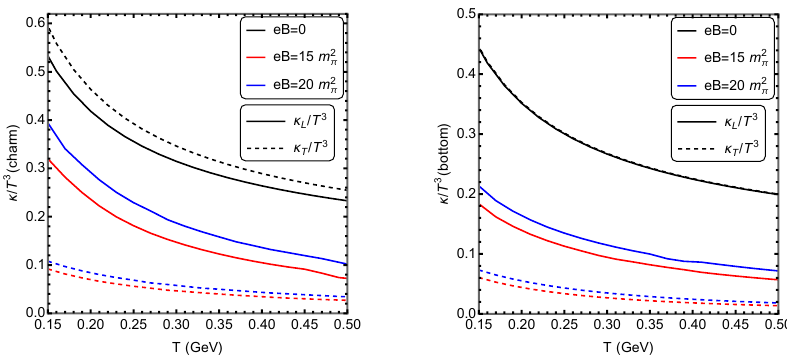
Figure 3. Variation of the scaled κ L (solid lines) and κ T (dashed lines) with temperature for three di ff erent values of external magnetic field, i.e. eB = 0 , 15 m 2 bottom (right panel) quarks, considering ⃗v (cid:113) ⃗ B . Charm and bottom quark masses M and HQ momentum p are specified in the text.